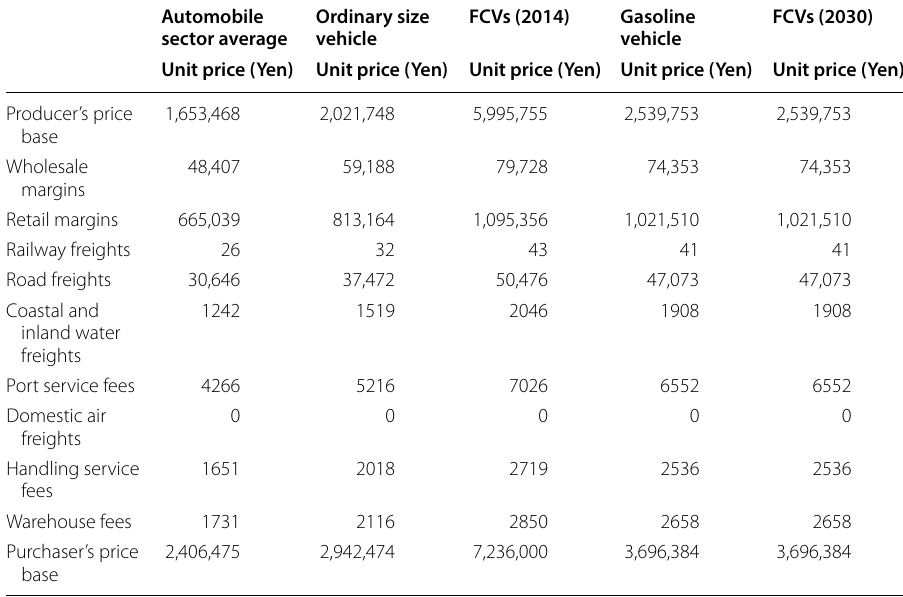
Table 5 Relationship between car purchaser price and producer price. Source : Authors’